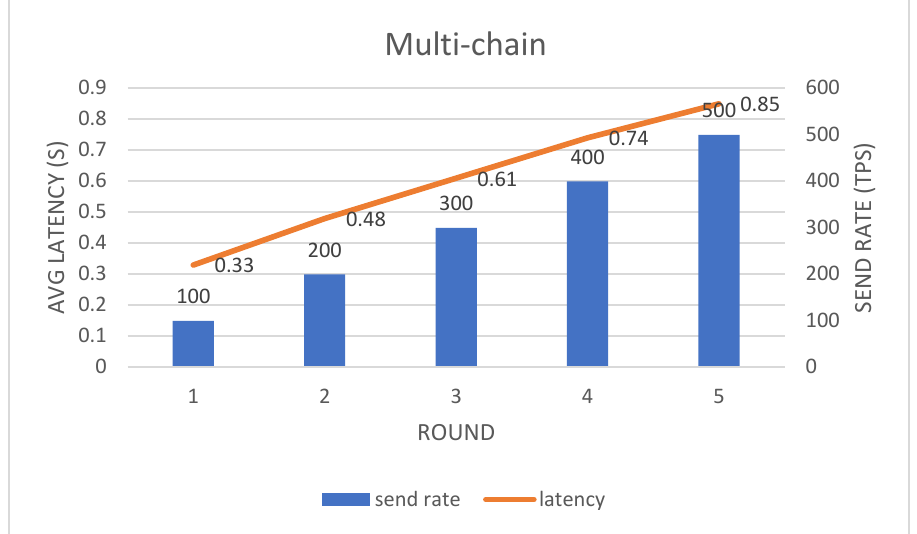
Figure 30. Network latency evaluation of multi-chain architecture.